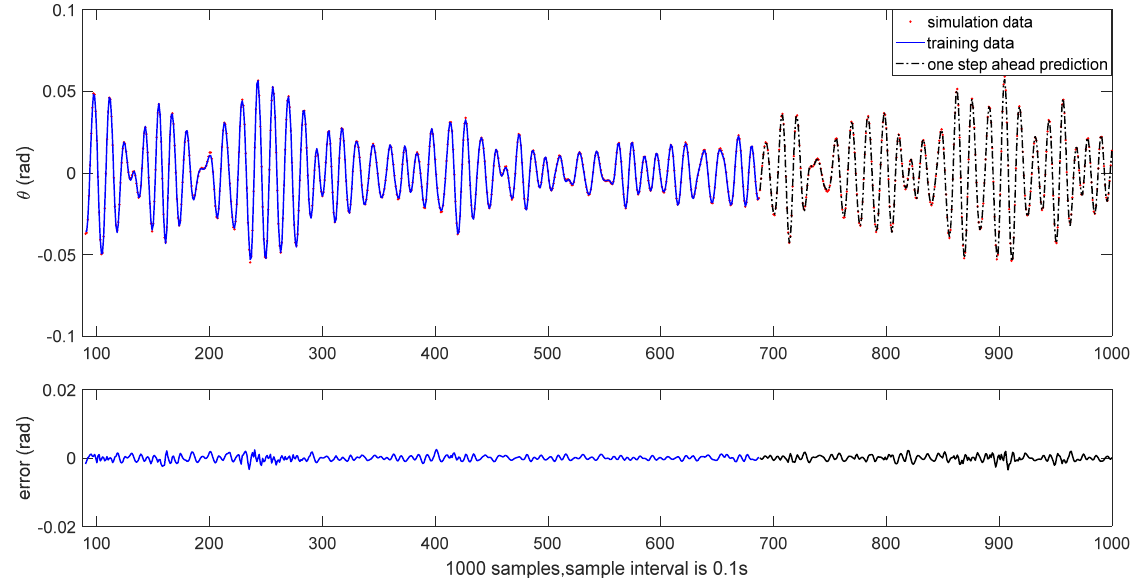
Figure 9. The one-step-ahead prediction of pitch motion in irregular waves at the instant k = 687 for the R-Class Icebreaker model.